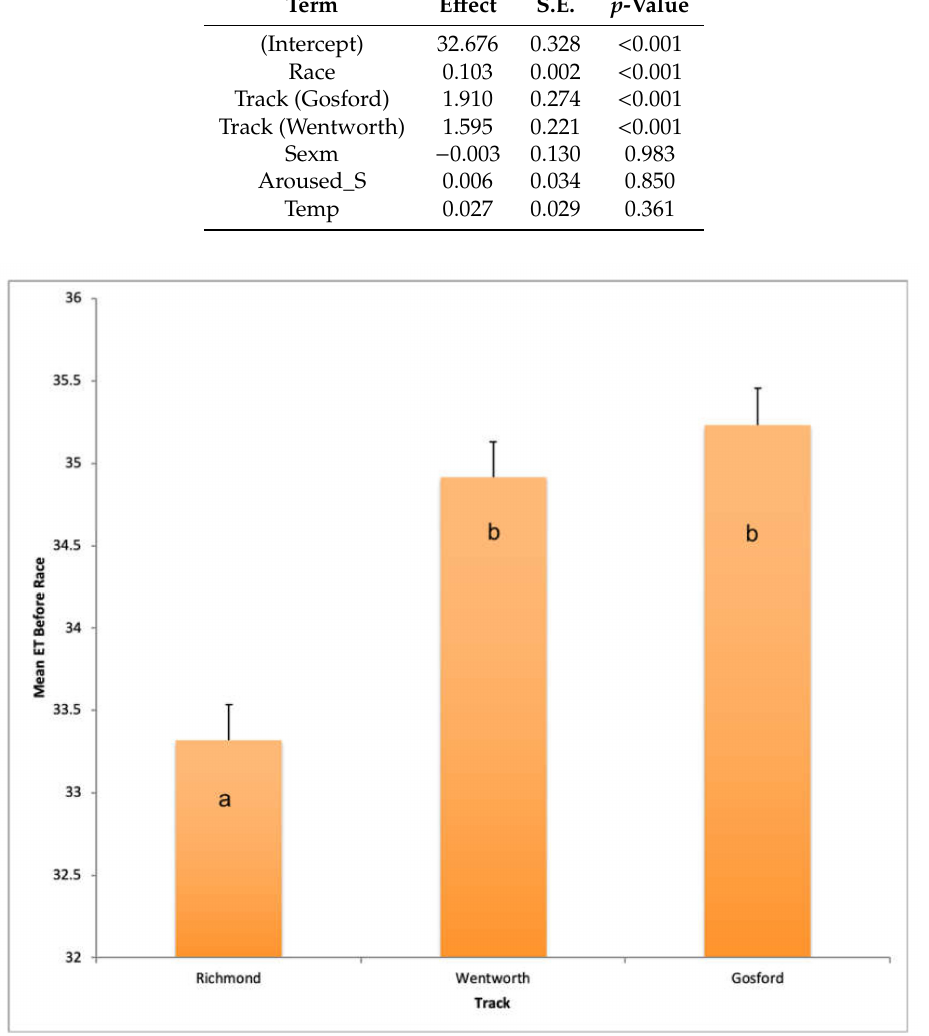
Figure 4. Fitted Eye Temp Before races at di ff erent tracks. Eye Temp Before was much lower at Richmond than the other two tracks, suggesting dogs are overall calmer at Richmond racetrack than Wentworth Park or Gosford. a,b Superscripts are assigned to values that are significantly di ff erent from one